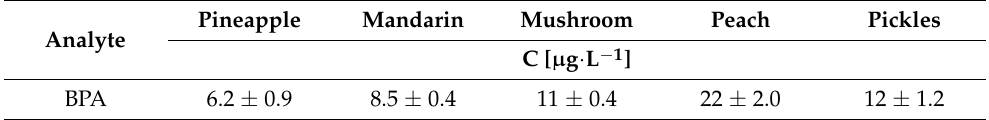
Table 2. The detected concentration of bisphenol A in liquid food samples after the extraction procedure. Analyte